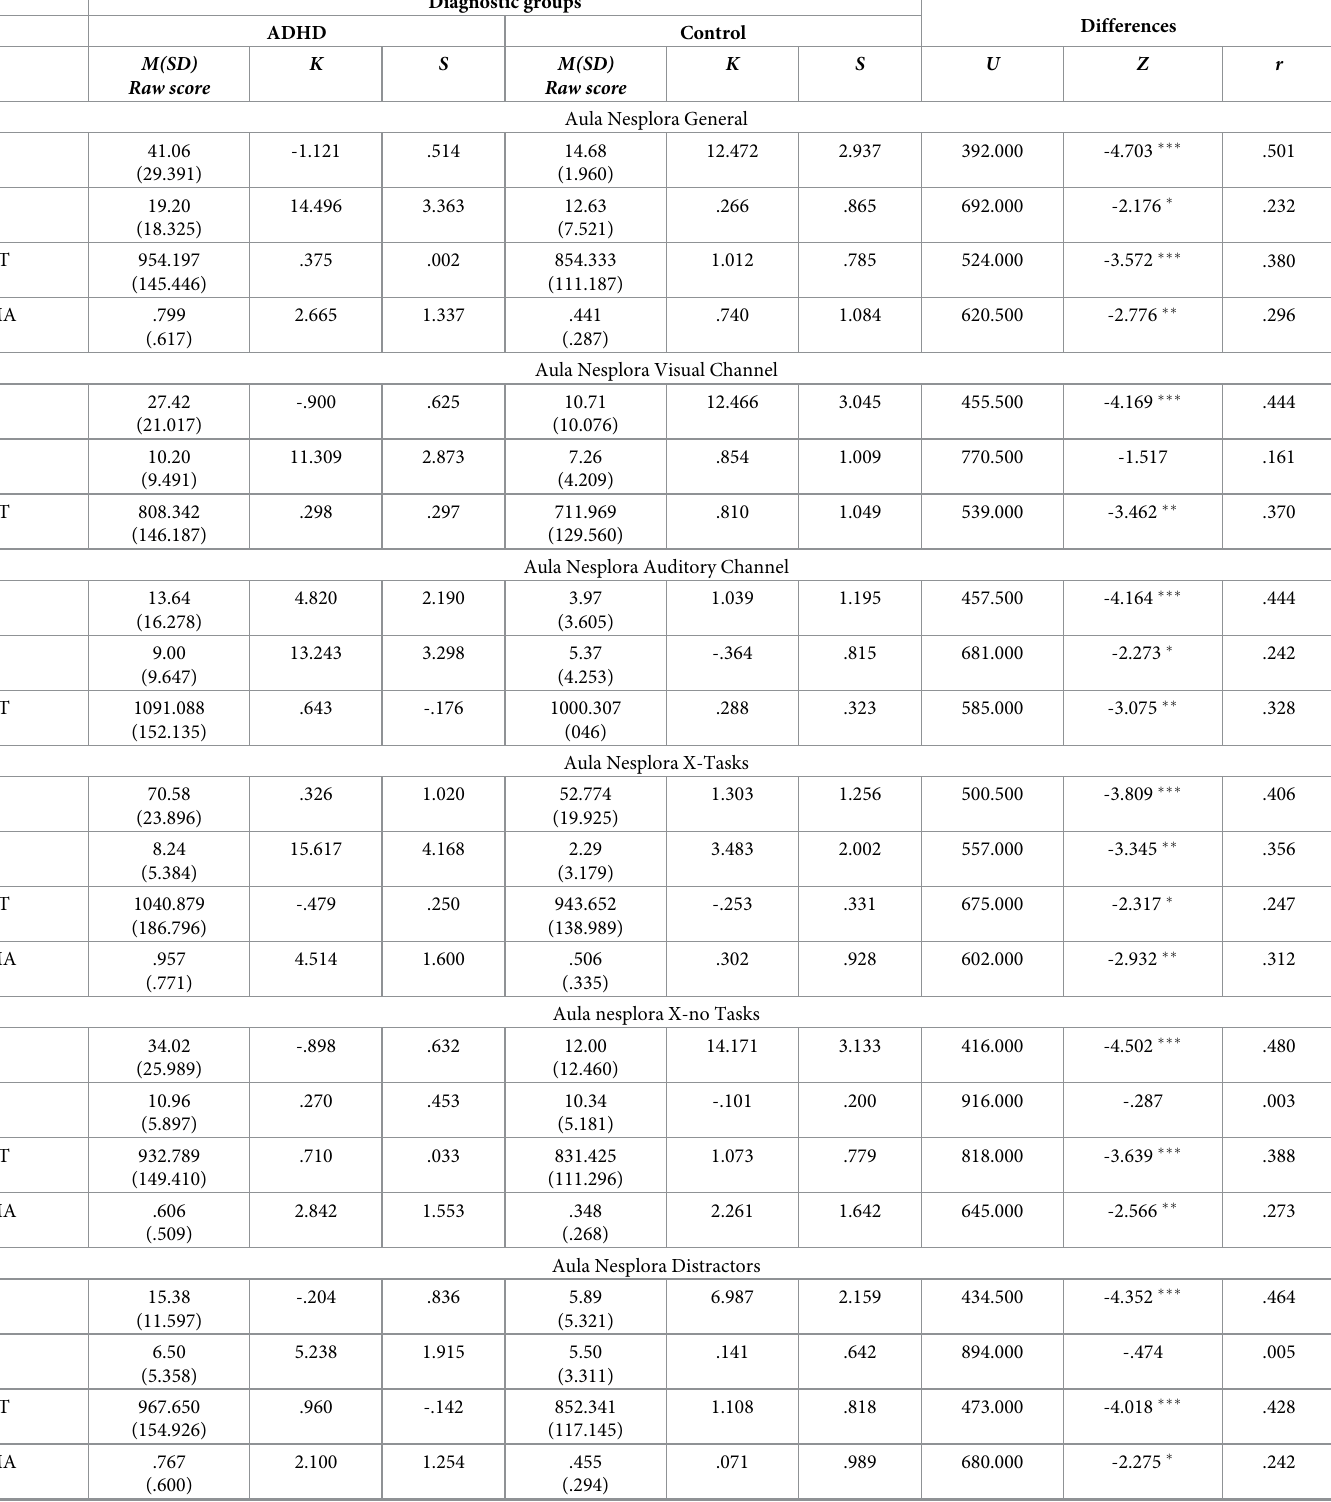
Diagnostic groups